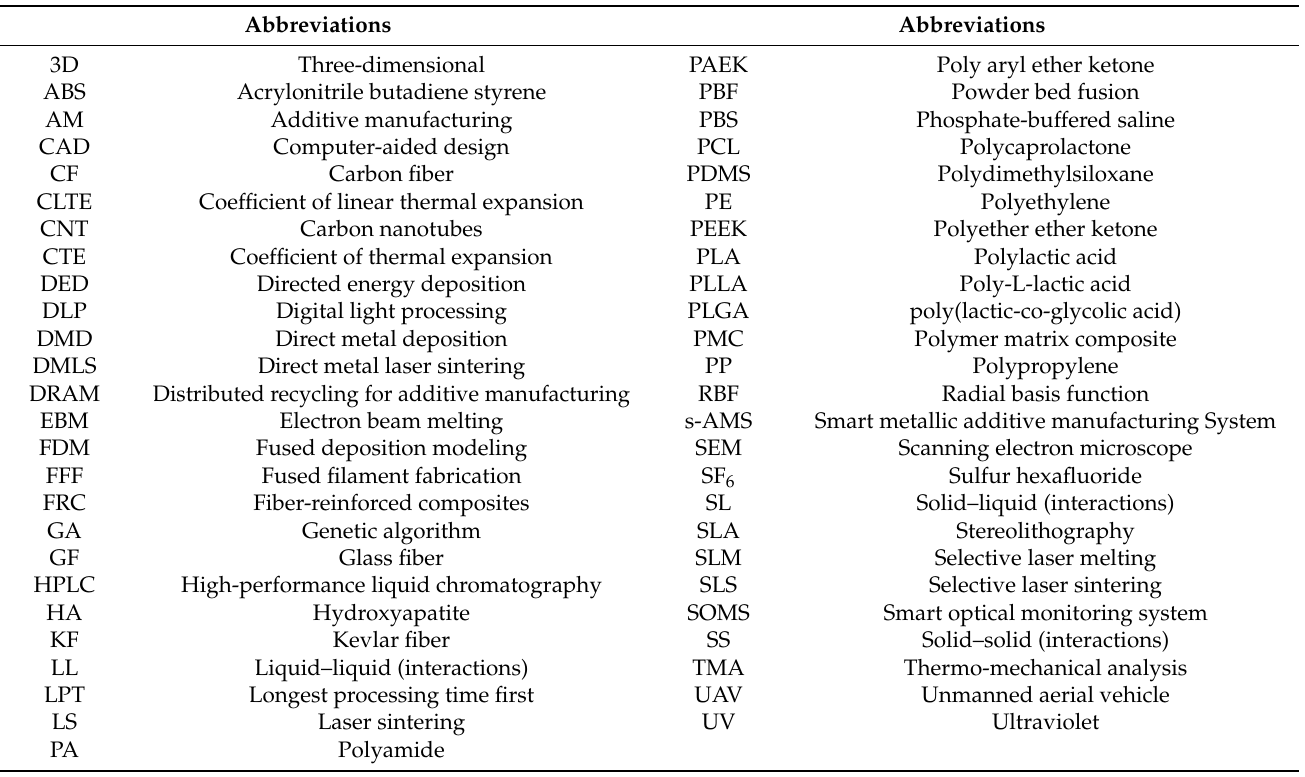
Table 2. Abbreviation used in the